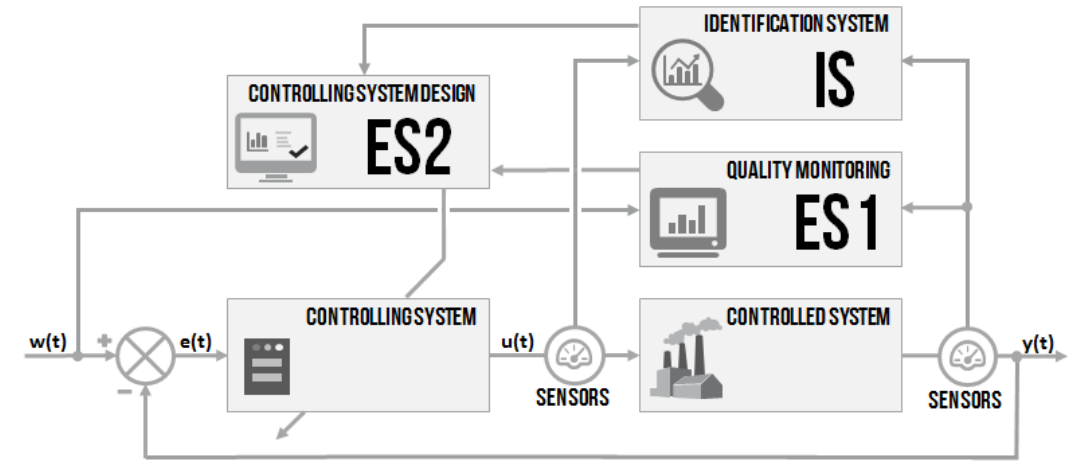
Figure 1. The schema of the proposed intelligent controlling system.